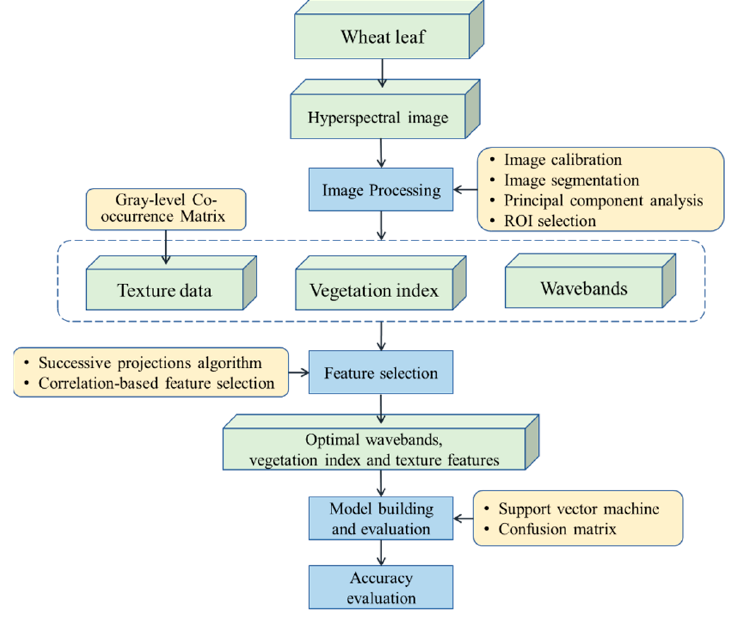
Figure 2. Flowchart of data analysis and processing.